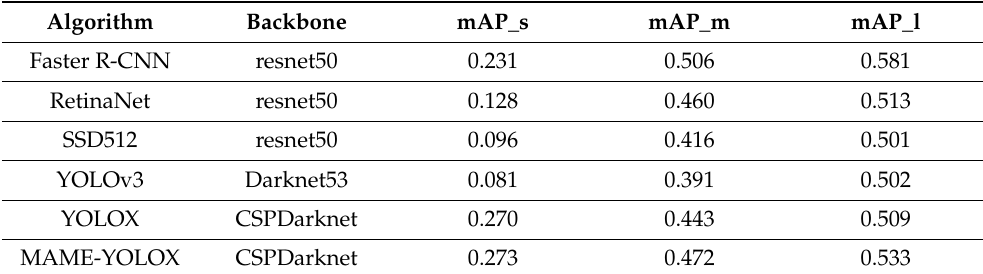
Table 5. Comparative experimental results of different algorithms on HRRSD